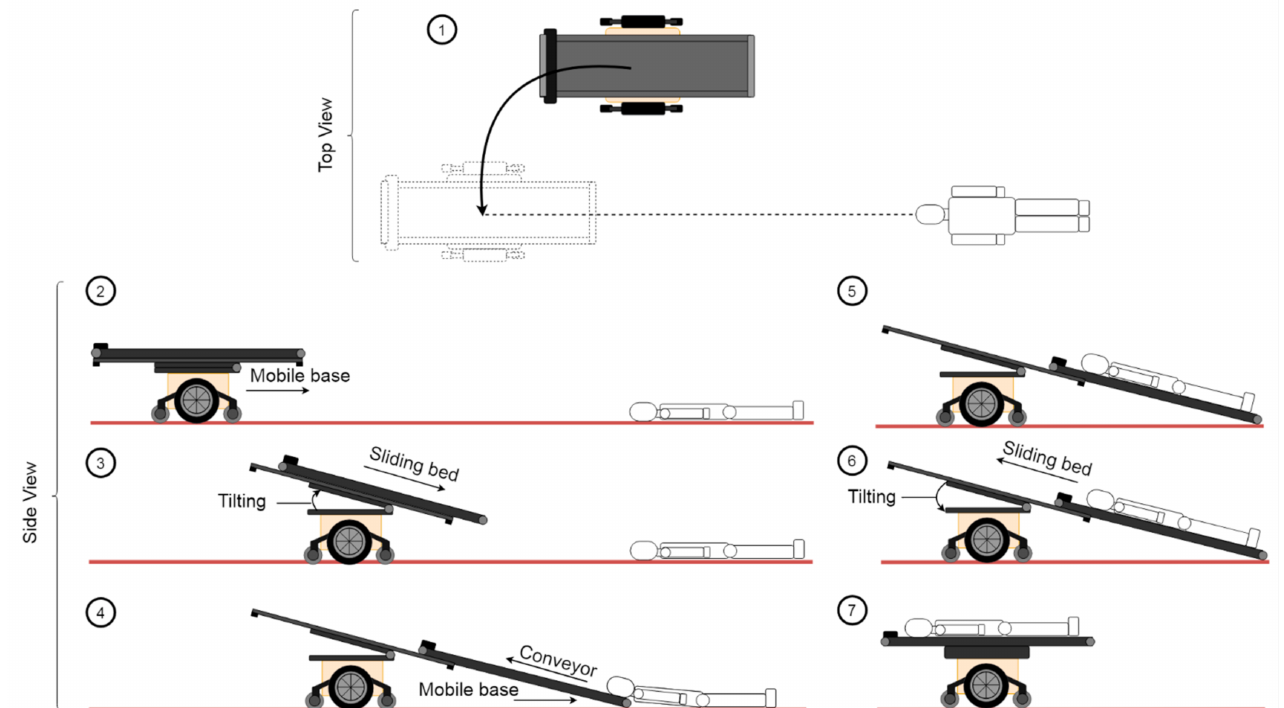
Figure 6. Illustration of the proposed casualty extraction procedure using ResQbot 2.0 comprising of seven main sequential phases: ( 1 ) Aligning the robot’s pose with respect to the casualty’s orientation. ( 2 ) Approaching the casualty in the desired target position in readiness to load the casualty. ( 3 ) Changing to the loading configuration by tilting and sliding the robot’s stretcher bed to the desired configuration. ( 4 ) Synchronising the robot’s mobile base and the conveyor belt movements enables the robot to gently load the casualty onto the stretcher bed. ( 5 ) Once the casualty is correctly positioned on the robot, the stretcher’s strap mechanism securely fastens, stabilises, and safely immobilises the casualty on the stretcher bed. ( 6 ) Changing back to the compact configuration by sliding up and tilting down the robot’s stretcher bed. ( 7 ) The robot is ready to transport the casualty to the medical area for further